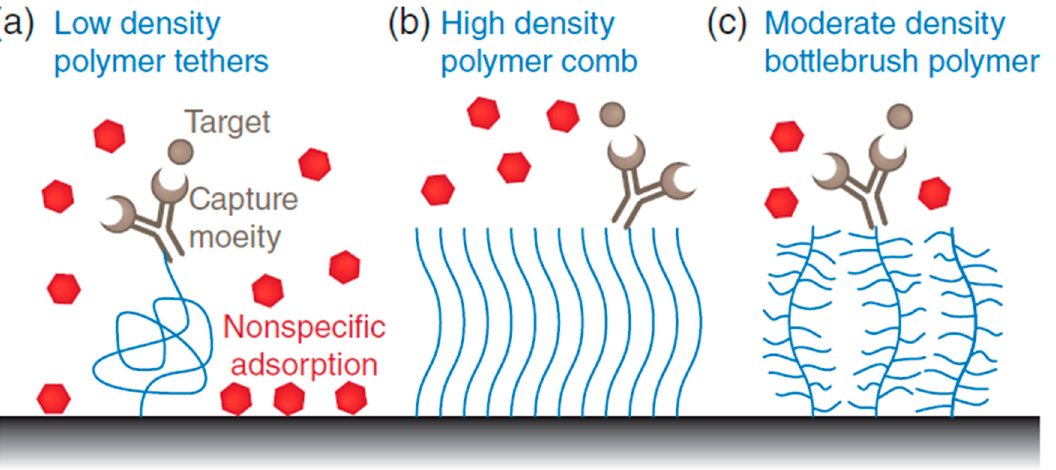
Figure 2. Schematic demonstration of the various surface grafting types of polymers. ( a ) Antibody grafted on a linear polymer and attached to a surface (at low density) enhances flexibility and allows access for capturing target molecules. There is a risk for non-specific attachment of other molecules on the empty gaps (fouling). ( b ) Polymer comb structure made from densely packed linear and hydrophilic polymers to produce antifouling effects. The attachment of targeting molecules will have better specificity. ( c ) Branched bottlebrush polymers are used at lower densities and demonstrate a better antifouling feature than linear polymers.